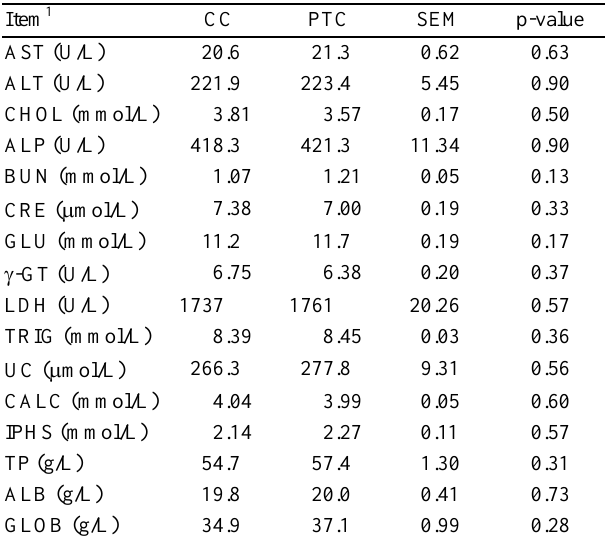
Table 3. Relative organ weights (g/kg BW) of laying hens